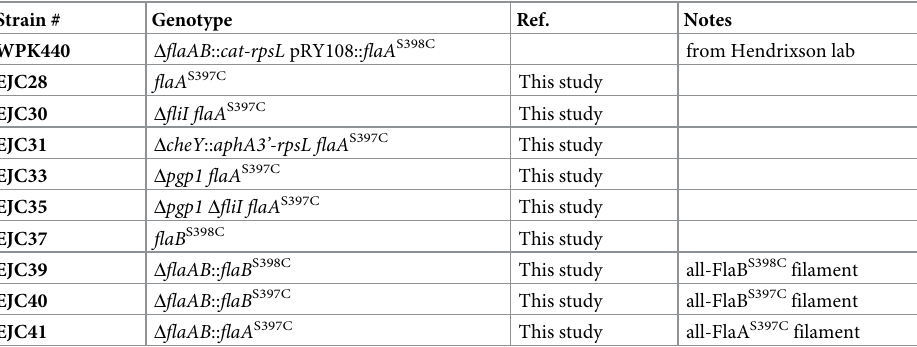
Table 1. List of strains used in this